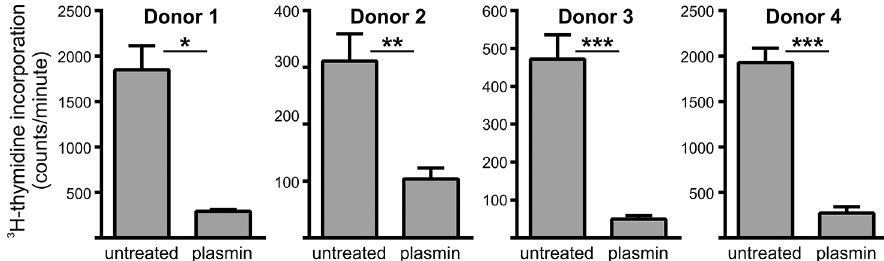
Fig 4. Plasmin-treatment of MoDCs suppresses allogeneic lymphocyte proliferation. MoDCs prepared from four different donors were treated with 100 nM plasmin for 24 h, then washed and incubated